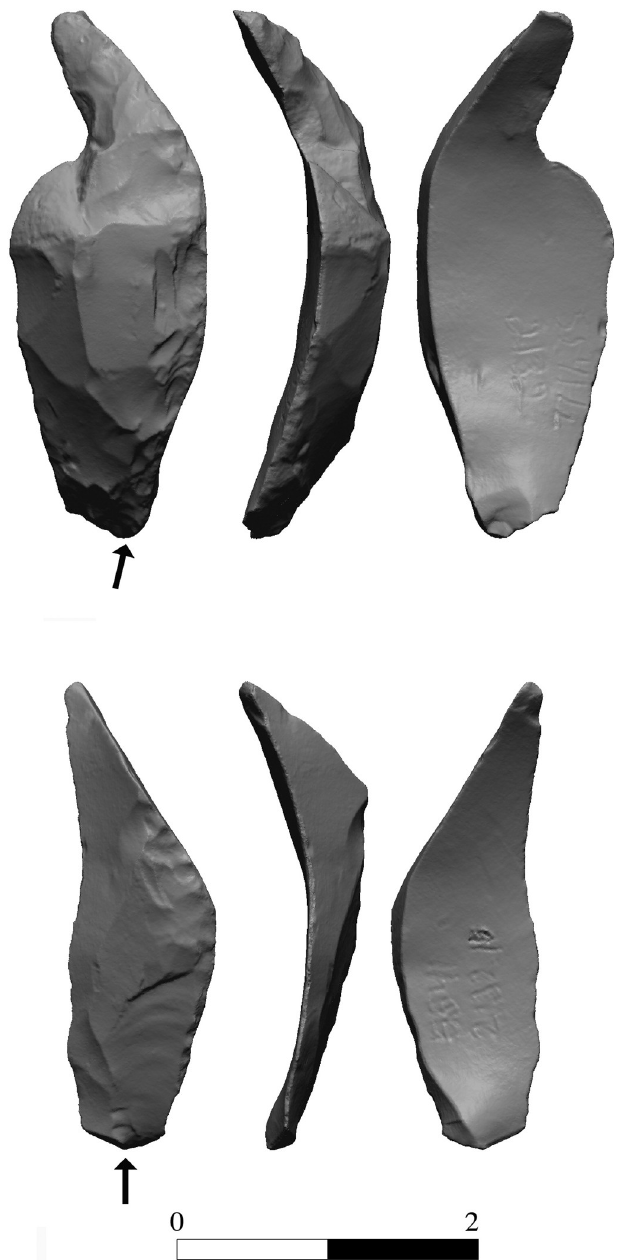
Fig 45. Bir el-Maksur PPNA site—lateral